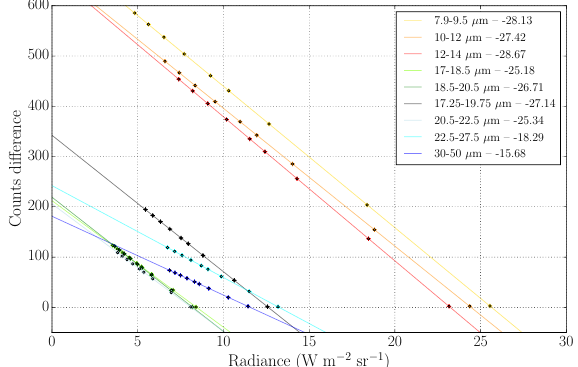
Figure 8. Counts’ difference between corrected signals on NBB and HBB in terms of NBB radiance in each spectral band of the FIRR. Dots indicate the average value for each temperature step. The stan- dard deviations among individual measurements are depicted by the error bars. The lines are the linear regressions, whose slopes are in- dicated in the legend.